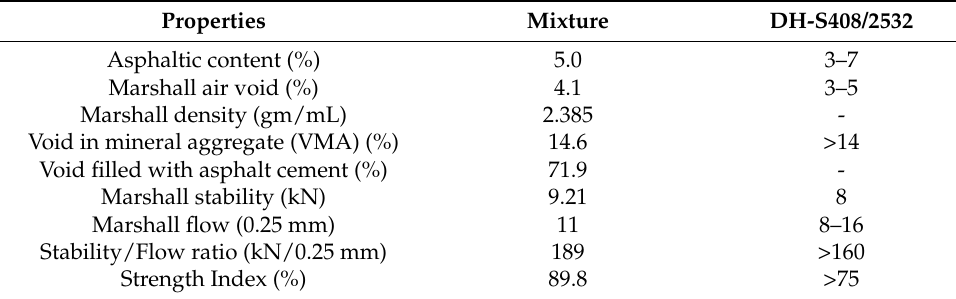
Table 3. Physical properties of asphalt